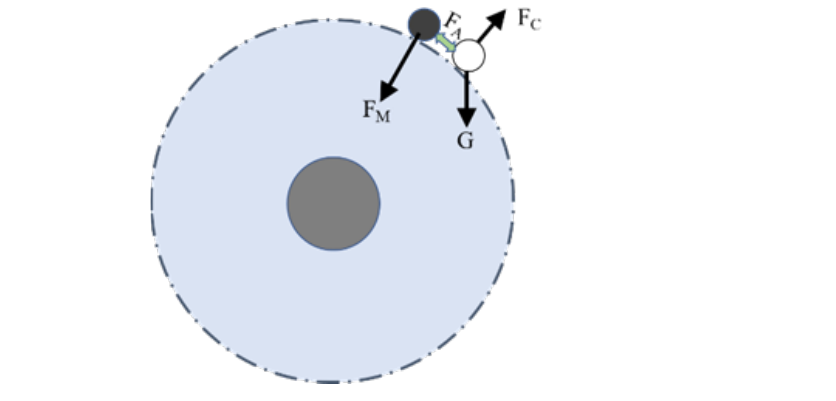
Figure 14. Dominant forces of the TDMS and MSIMS during their operation.